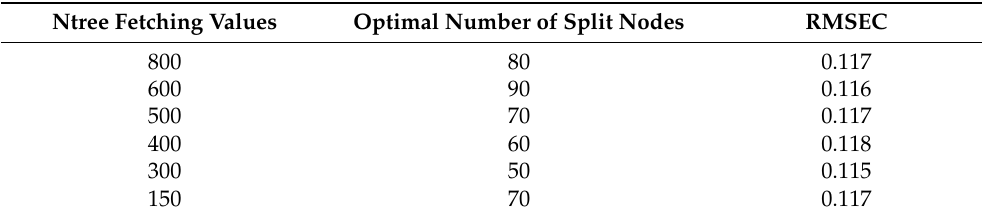
Table 5. Nitrogen content tree number and split node number setting and RMSEC statistical